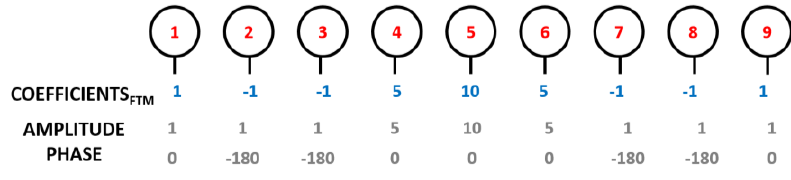
Figure 7. Antenna array weights.